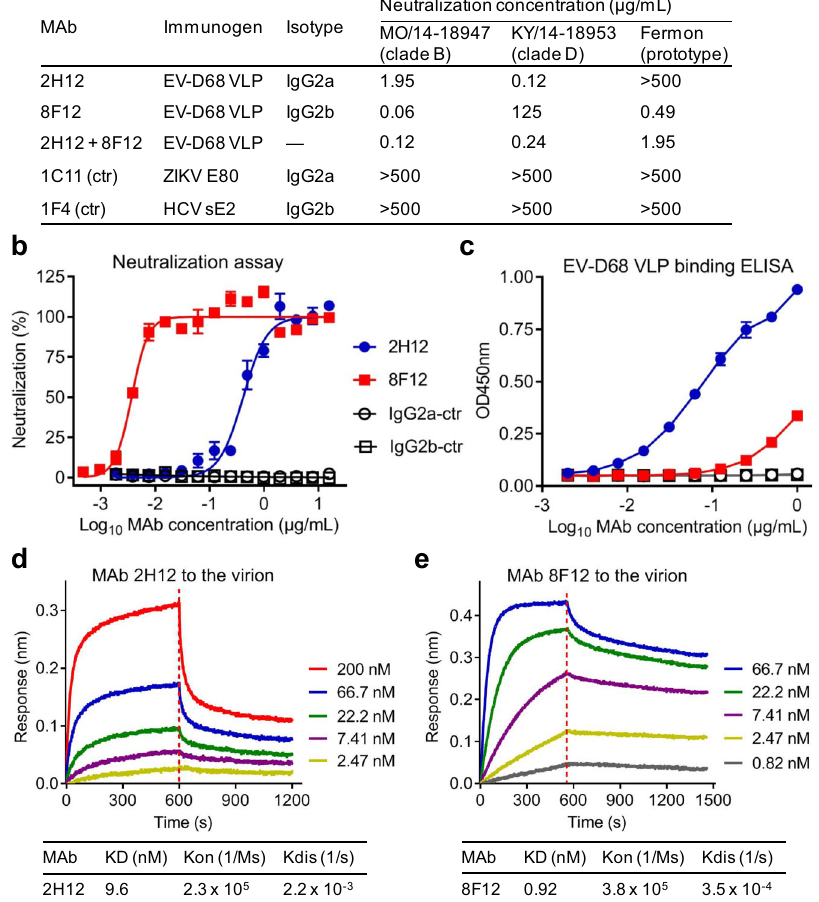
Fig. 1 Neutralization activity and binding properties of the MAbs. a Isotypes and neutralization activity of anti-EV-D68 MAbs. Neutralization concentrations of the MAbs were de fi ned as the lowest antibody concentrations that completely prevented virus-induced cytopathic effect. 2H12 + 8F12, MAbs 2H12, and 8F12 were combined at a ratio of 1:1. ctr, isotype control. Symbol ( — ), not tested. b Neutralization activity of the MAbs against EV-D68. 100 TCID 50 of EV-D68 strain 18947 was incubated with two-fold serial dilutions of puri fi ed MAbs 2H12 and 8F12 for 1 h before adding to RD cells. Cell viability was measured by CellTiter-Glo 2.0 assay 3 days after infection. Data are expressed as mean ± standard error of mean (SEM) of triplicate wells. c Reactivities of the MAbs towards EV-D68 VLP determined by ELISA. Data are expressed as mean ± standard deviation (SD) of triplicate wells. In panels ( b , c ), ZIKV-speci fi c MAb 1C11 and HCV-speci fi c MAb 1F4 served as IgG2a and IgG2b isotype controls (ctr), respectively. d, e Binding af fi nities of the MAbs to EV-D68 18947 virion measured by BLI. Association and dissociation steps are divided by dotted red line. MAb concentrations used and values of KD, Kon and Kdis